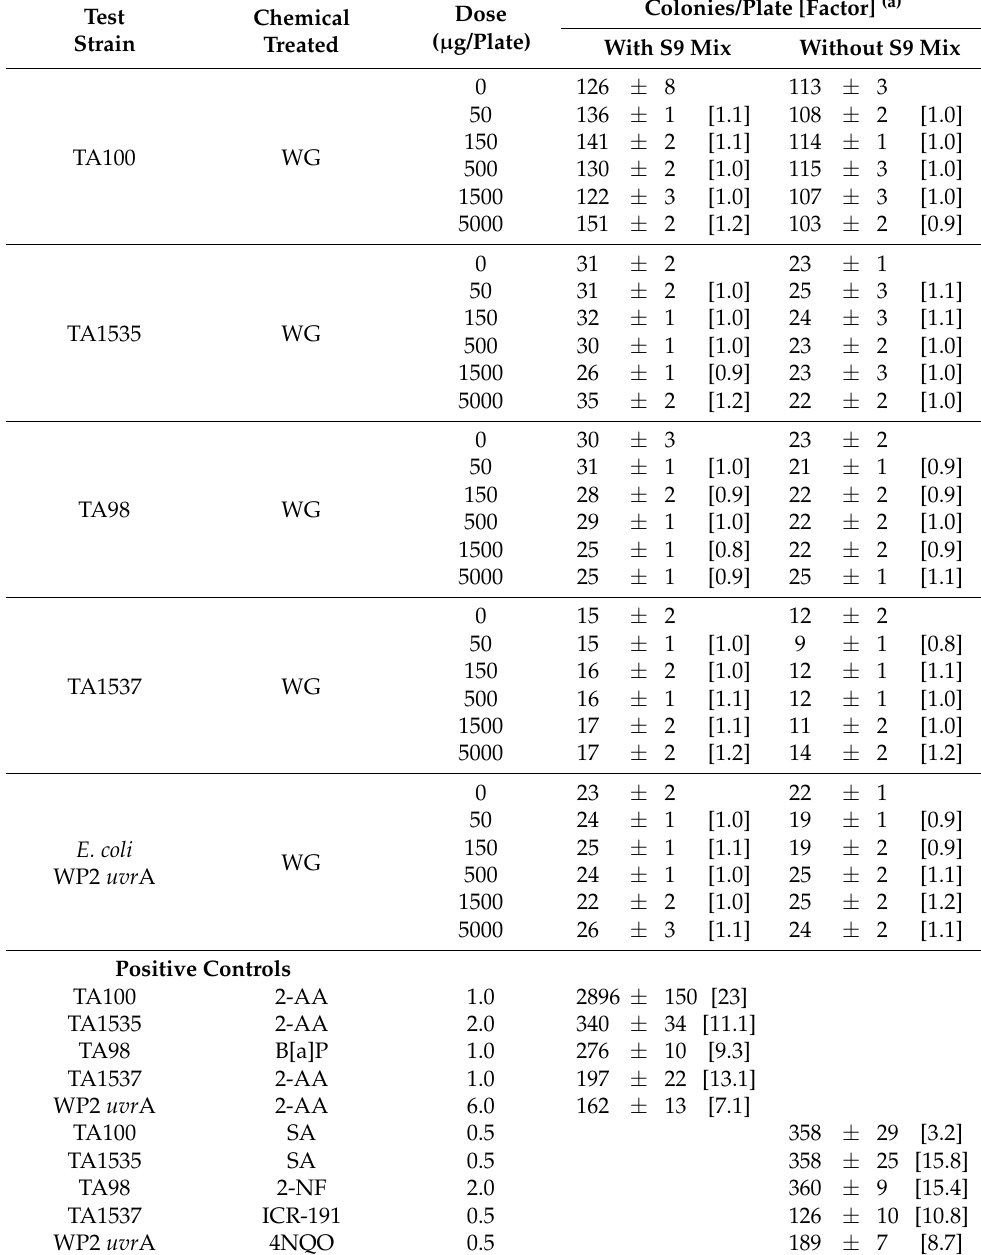
Table 1. In vitro Ames test of WG